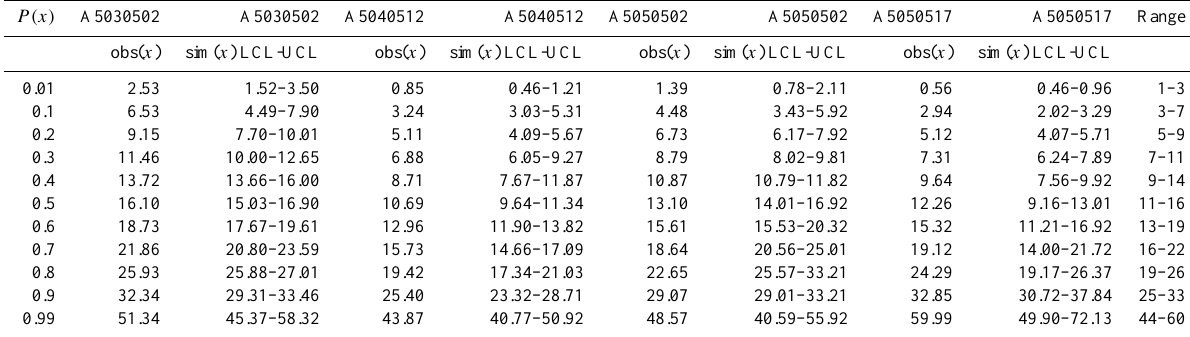
Table 6. Estimated IL quantiles for selected non-exceedance